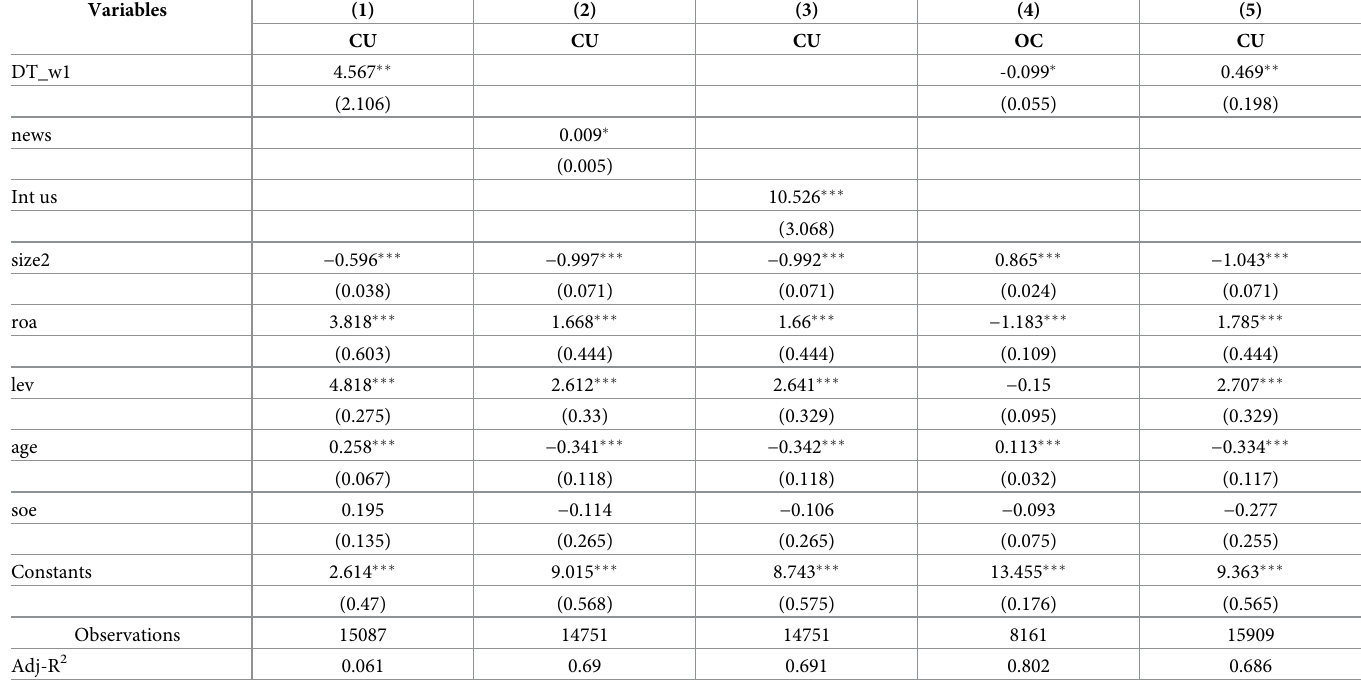
Table 4. Results of robustness